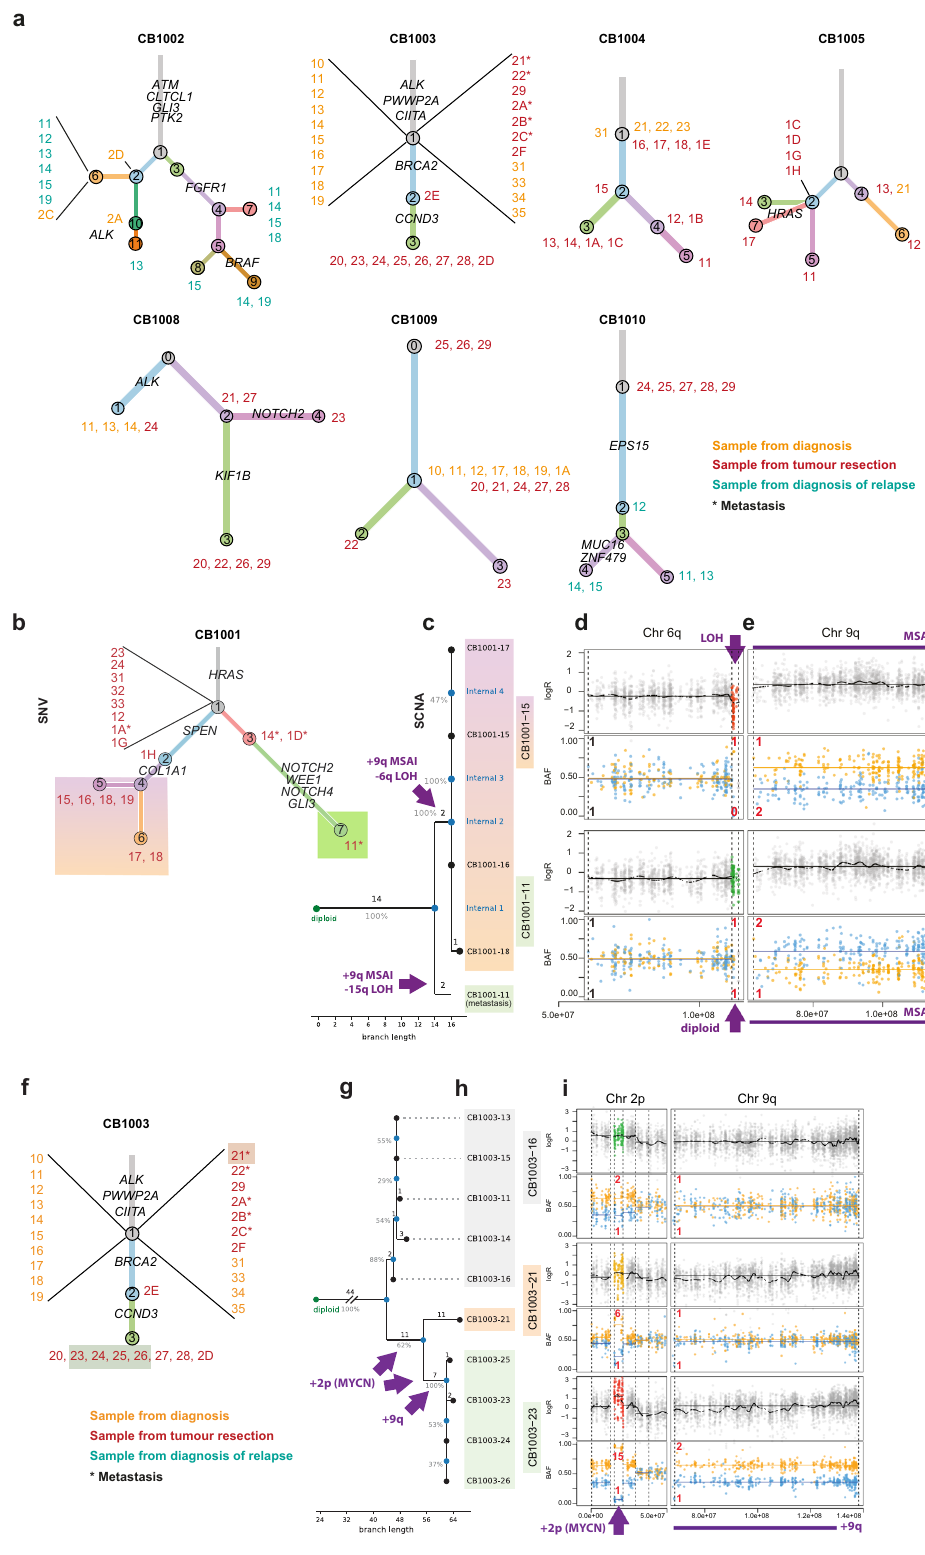
resectionSample from diagnosis Sample from tumour Sample from diagnosis of relapse *